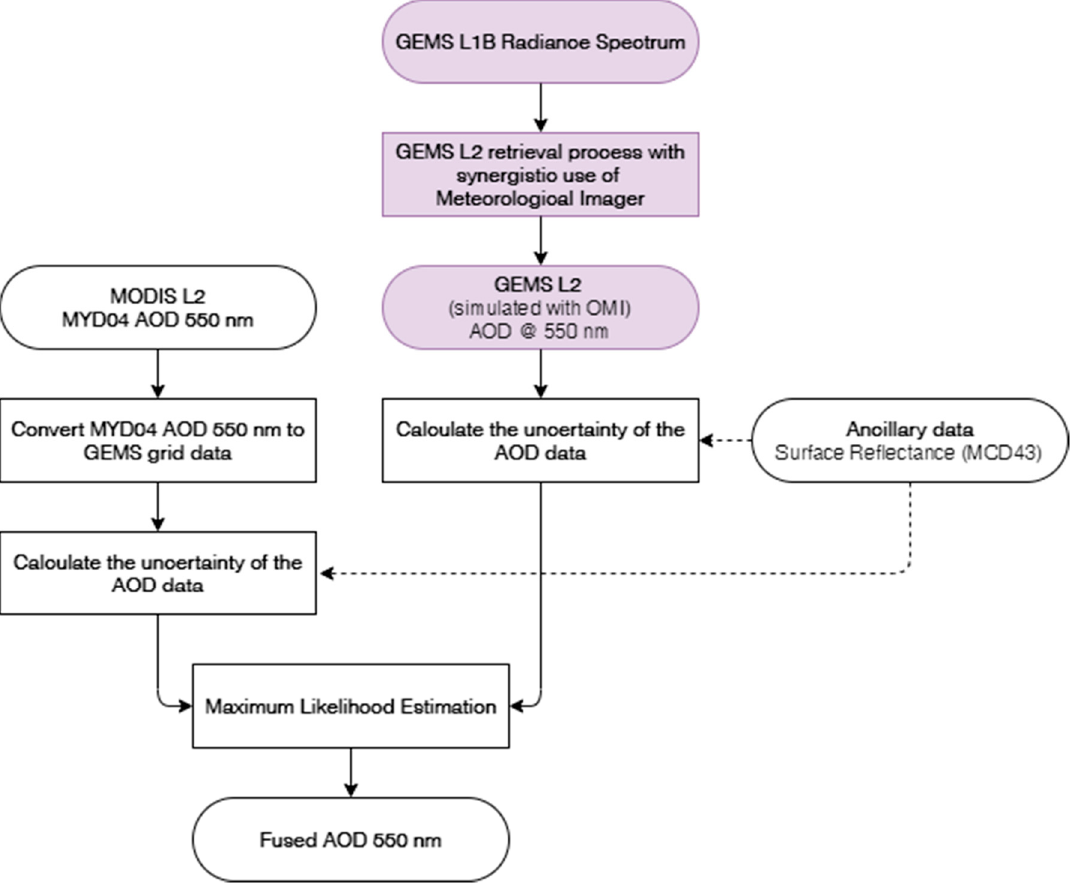
Figure 2. Flowchart describing synergistic use of meteorological instruments to create ‘best’ aerosol optical depth (AOD) datasets by merging individual AOD products. Purple-shaded components correspond to Figure 1.